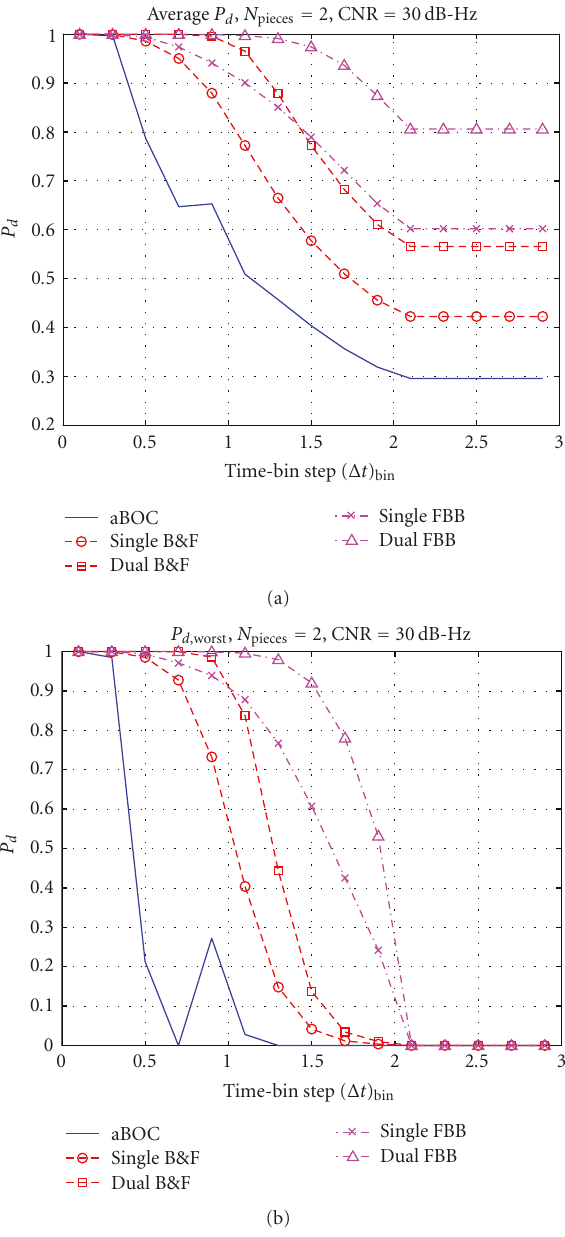
Figure 8: Average (upper) and worst (lower) detection probabili- ambiguous and unambiguous BOC acquisition ties versus ( Δ t ) bin methods (FBB ep was used